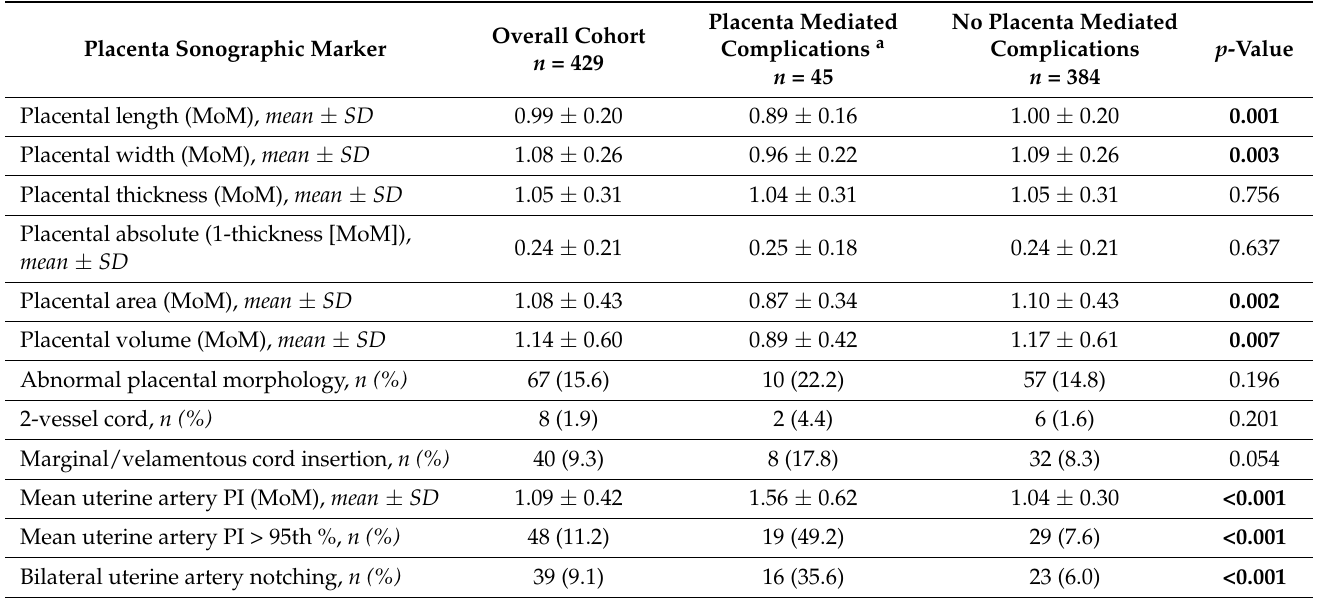
Table 2. Distribution of the sonographic markers in patients with and without placenta-media- ted complications.